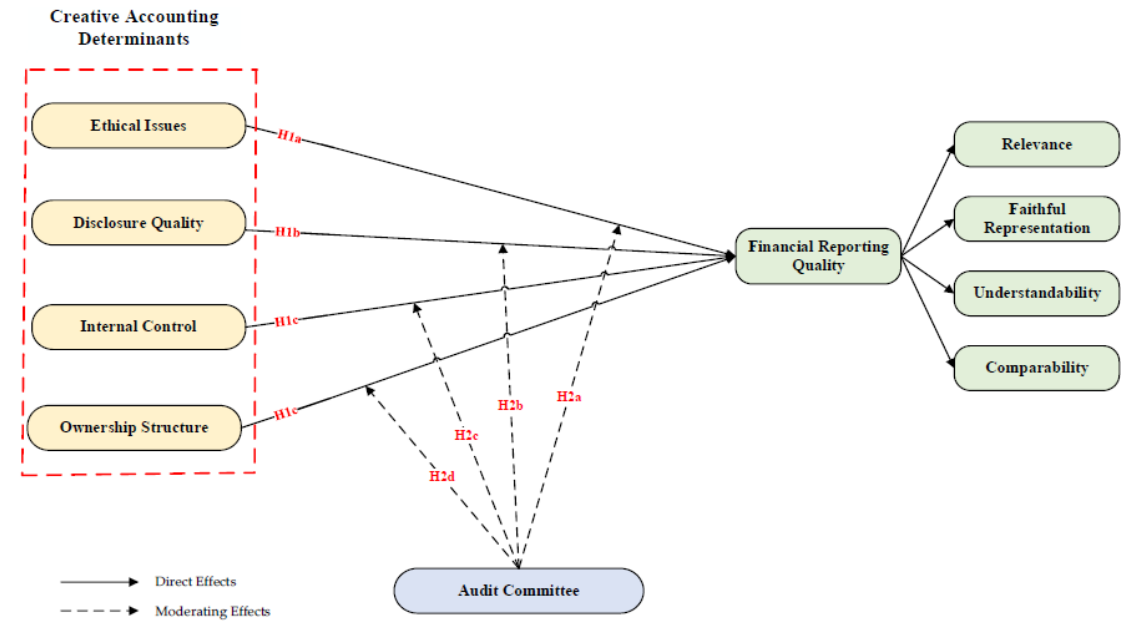
Figure 1. Conceptual framework of the current